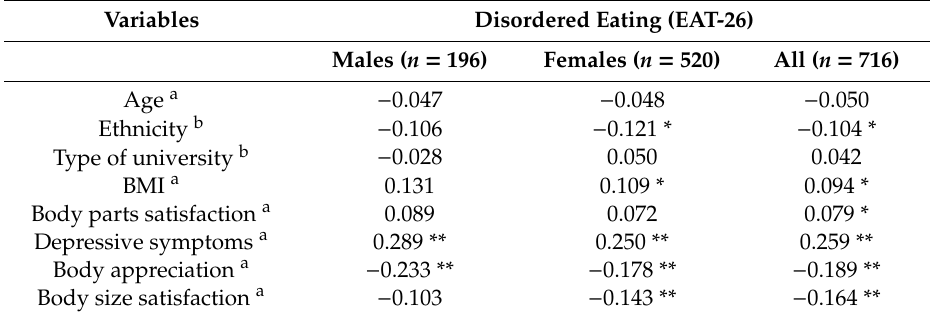
Table 3. Correlates of disordered eating with body mass index (BMI), socio-demographic characteristics, and psychological factors of university students.